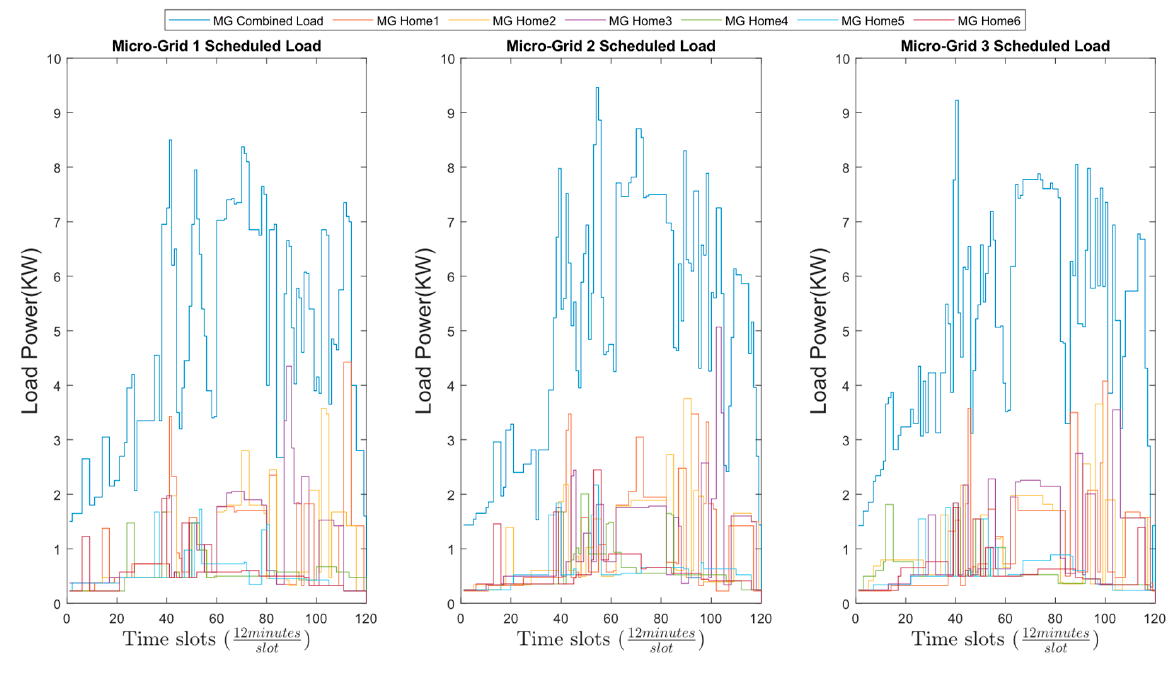
Figure 23. Scheduled load curve of MG 1 , MG 2 , and MG 3 using MJLBO for scenario 3.